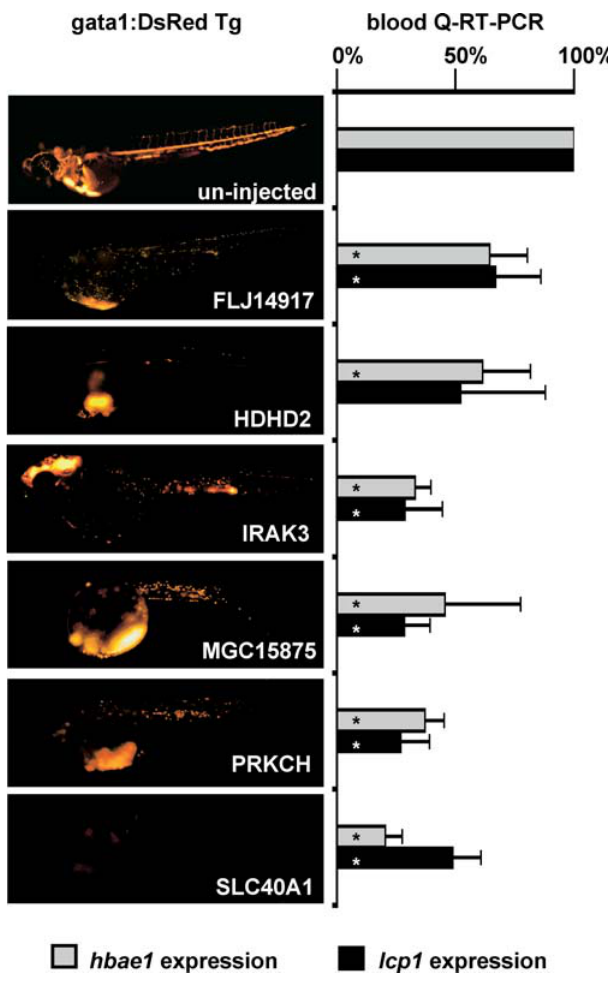
Figure 3. Representative Hematopoietic Phenotypes Observed in MO- Targeted Zebrafish Fluorescence microscopic images of gata1: DsRed Tg zebrafish embryos display the hematopoietic phenotypes observed for six MO-targeted zebrafish embryos compared to an uninjected control. Phenotypes shown are representative of greater than 70% of injected embryos at 48 hpf (greater than or equal to three experiments of n . 40 embryos). Hematopoietic defects were quantified by Q-RT-PCR for the expression of erythroid-specific hbae1 and myeloid-specific lcp1 transcripts in MO- targeted embryos relative to uninjected clutchmate controls (greater than or equal to three experiments of n ¼ 5 embryos; * p , 0.05). DOI: 10.1371/journal.pbio.0030254.g003